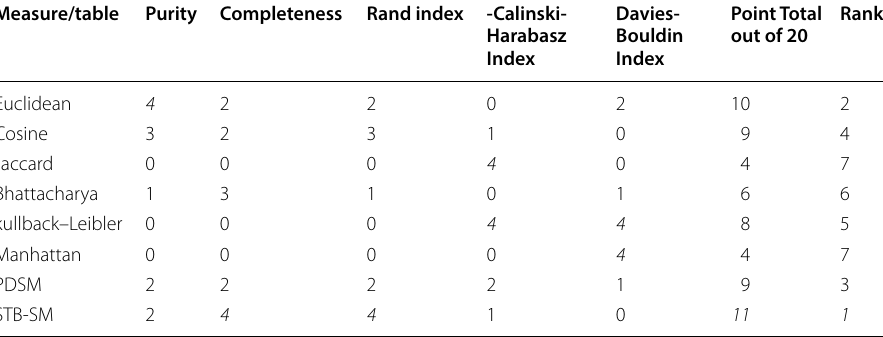
Italic values indicate the high-ranking similarity measure